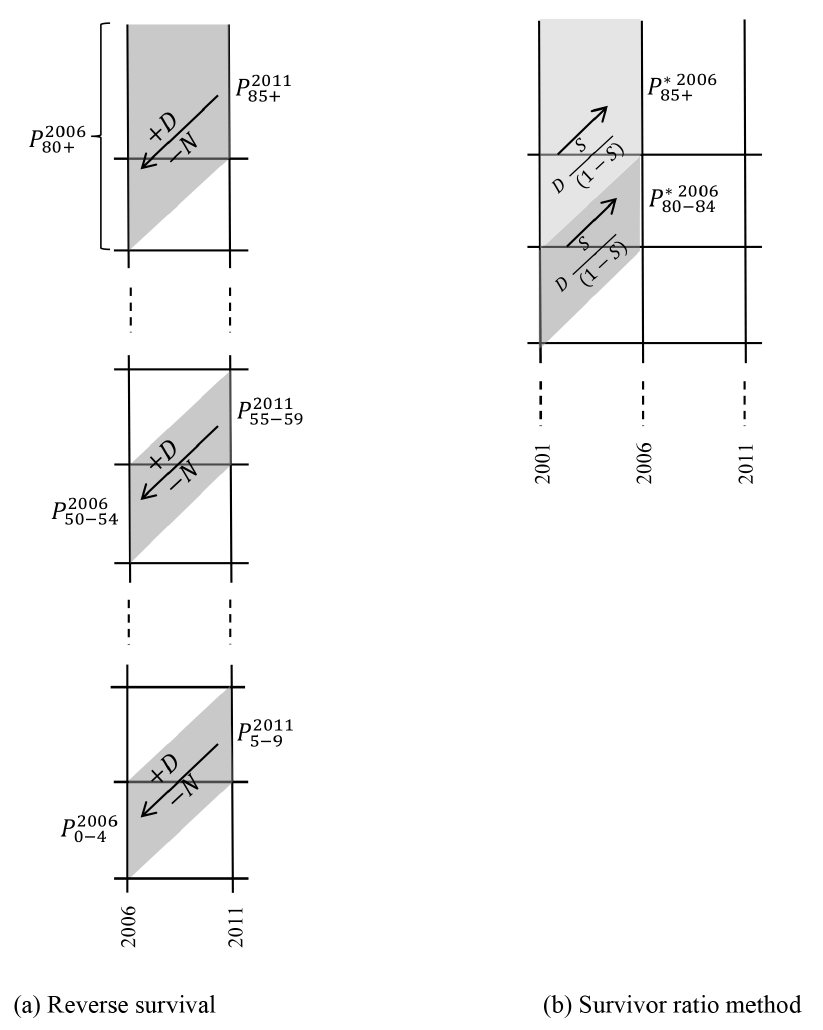
Figure 5. Lexis diagram illustration of (a) reverse cohort survival estimation and (b) the survivor ratio method for calculating preliminary 80–84 and 85 + populations.